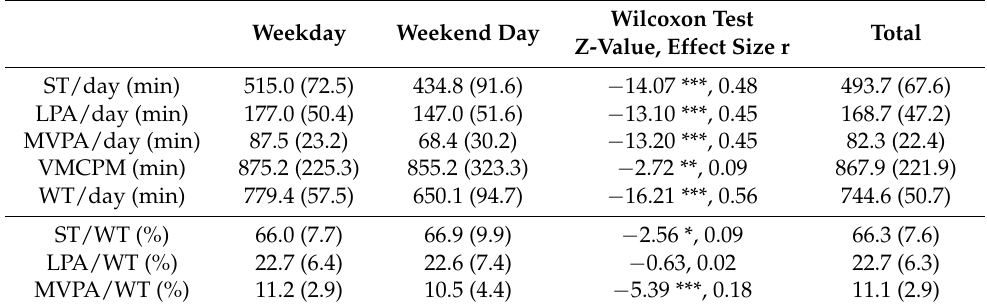
Table 1. Sedentary and physical activity behavior in minutes and in percent of wear time (mean (SD)) on average weekdays, weekend days and in total (N = 425).